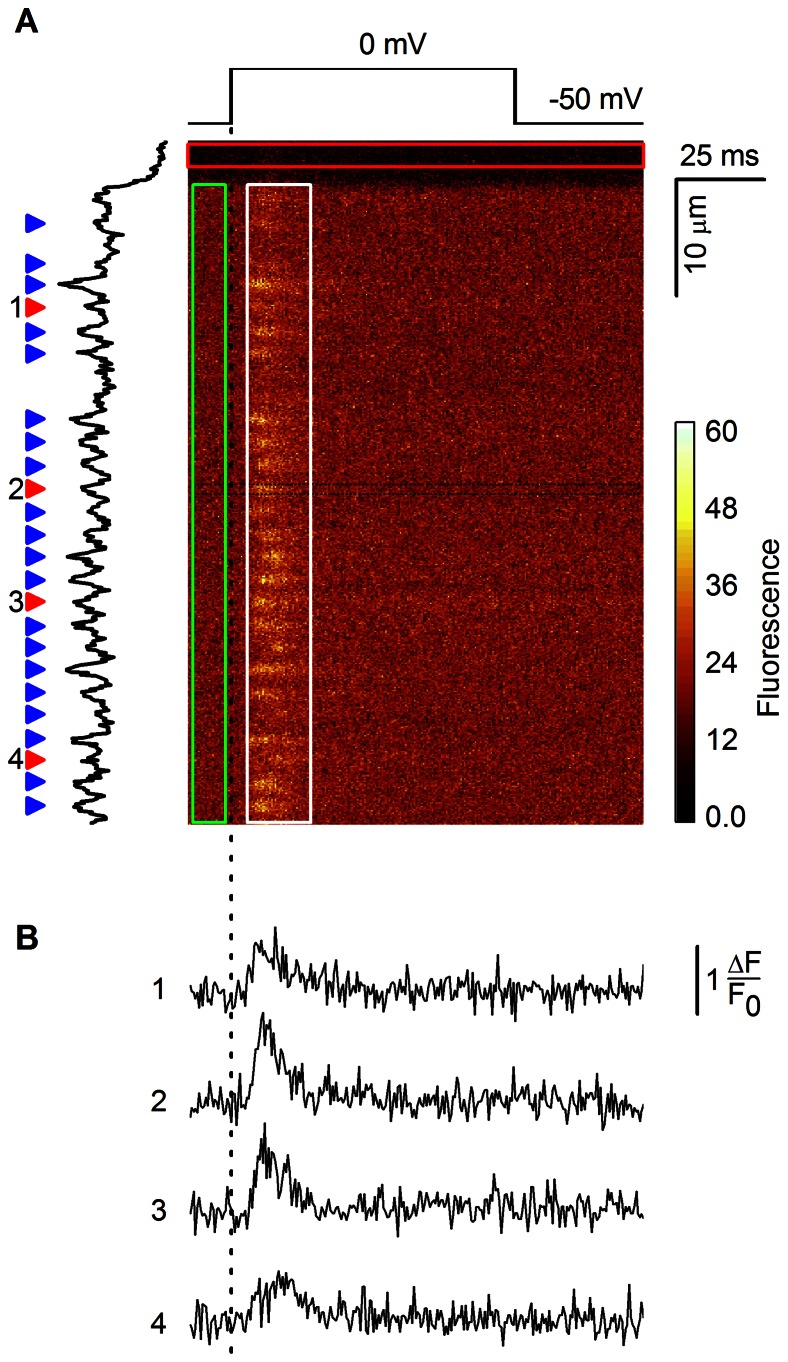
Detection and extraction of calcium spikes for analysis.A: a line scan confocal (x-t) image with three indicated regions of interest. The fluorescence intensity is color-coded. The red rectangle delineates the non-cell region used for estimation of the background fluorescence level. The green rectangle delineates the scan region preceding the stimulus (shown above the image) that is used for estimation of baseline cell fluorescence and the level of noise. The white rectangle delineates the region of image chosen for calcium spike detection. The black trace at the left represents the temporal average of fluorescent intensity of the pixels in the white rectangle. The arrowheads mark calcium spikes selected for analysis. B: The time courses of the fluorescent profiles of the spikes marked by the numbered red arrowheads in A. The traces were obtained by averaging 7 spatial pixels delineated by the thin black lines indicated around the calcium spike #2. The time scale is the same for A and B.